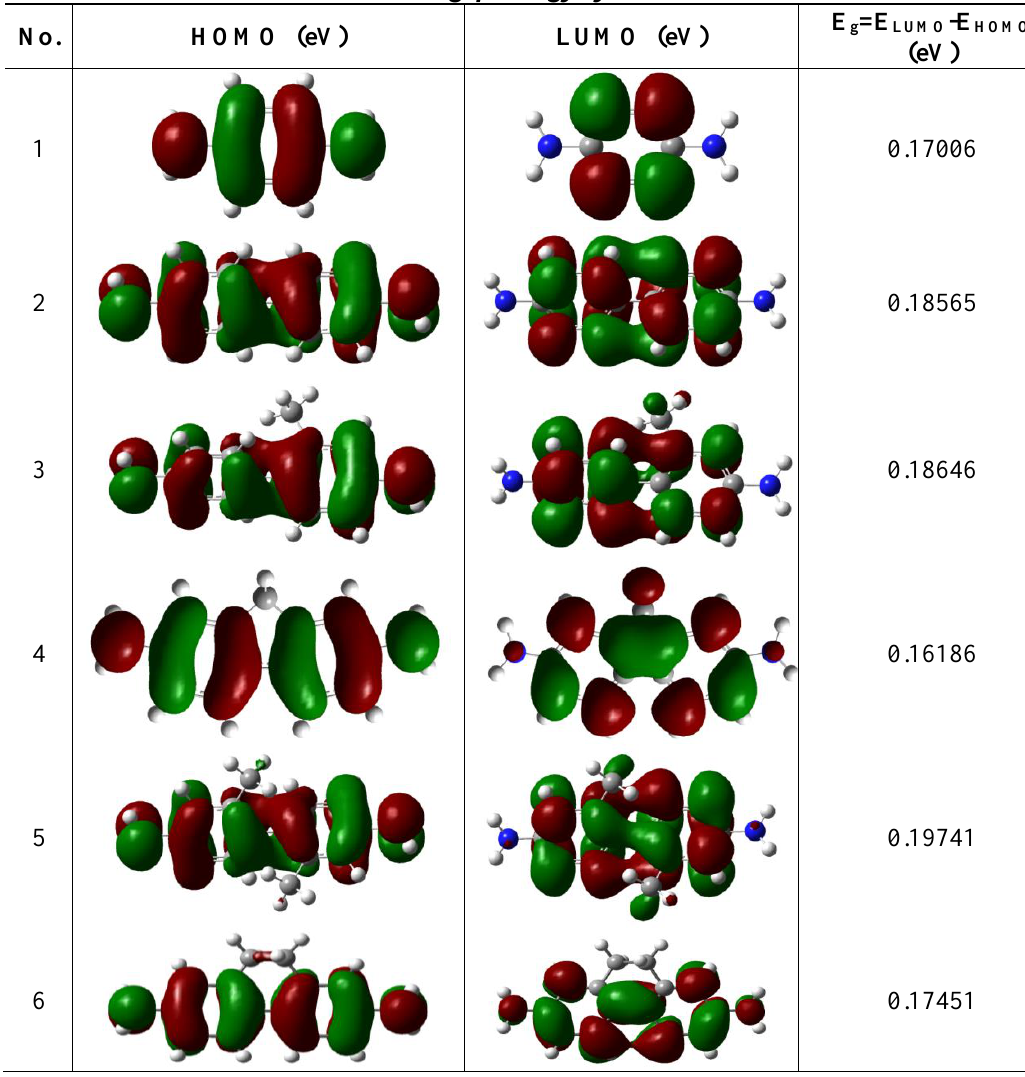
Table 3: The Frontier Orbitals for six molecular structures at different side groups with band gap energy by